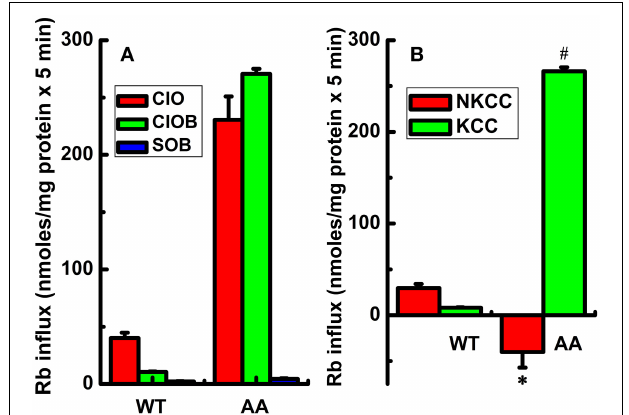
FIGURE 1 | Constitutive KCC3 Thr991/Thr1048 dephosphorylation stimulates KCC3 activity and is accompanied by a reversal of NKCC1 activity. Rb + influx assays in isogenic cell lines harboring doxycycline-inducible expression of either KCC3 wild type (WT) or non-phosphorylatable KCC3 Thr991A/Thr1048A (AA) were performed as described in Methods. (A) Rb + influx was assessed in the following media: Cl − + 0.1mM ouabain (ClO, red), Cl − + (ouabain + 10 µ M bumetanide) (ClOB, green), S + (ouabain + bumetanide) (SOB, blue) after induction of the indicated proteins (see Methods for details). (B) Calculated Rb + flux through NKCC and KCC as the Cl-dependent, ouabain-insensitive, bumetanide-sensitive Rb + influx (ClO - ClOB), and Cl-dependent, ouabain and bumetanide-insensitive Rb + influx (ClOB - SOB), respectively. Calculation of NKCC in AA cells after induction resulted in a negative value due to a larger Rb + influx in ClOB than in ClO, i.e., CLO – CLOB = -NKCC (see Results and Discussion for further details). Flux time, 5min; n = 9 individual determinations for WT cells and n = 4 individual determinations for AA cells. Total number of independent experiments N = 4 for WT and N = 5 for AA cells. Results were similar among different cell clones for both WT and AA. * p < 0 . 005 ; # p < 0 . 0005 ; data represent the mean ± SEM values. Two-sample t -test was employed to determine the statistical significance of the differences between WT and AA, as indicated.